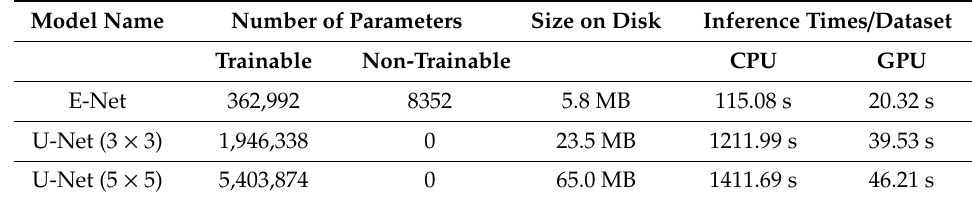
Table 4. Comparison of computational complexity and performance of the two deep learning (DL) models. For U-Net, both implementations based on 3 × 3 and 5 × 5 filters were considered.